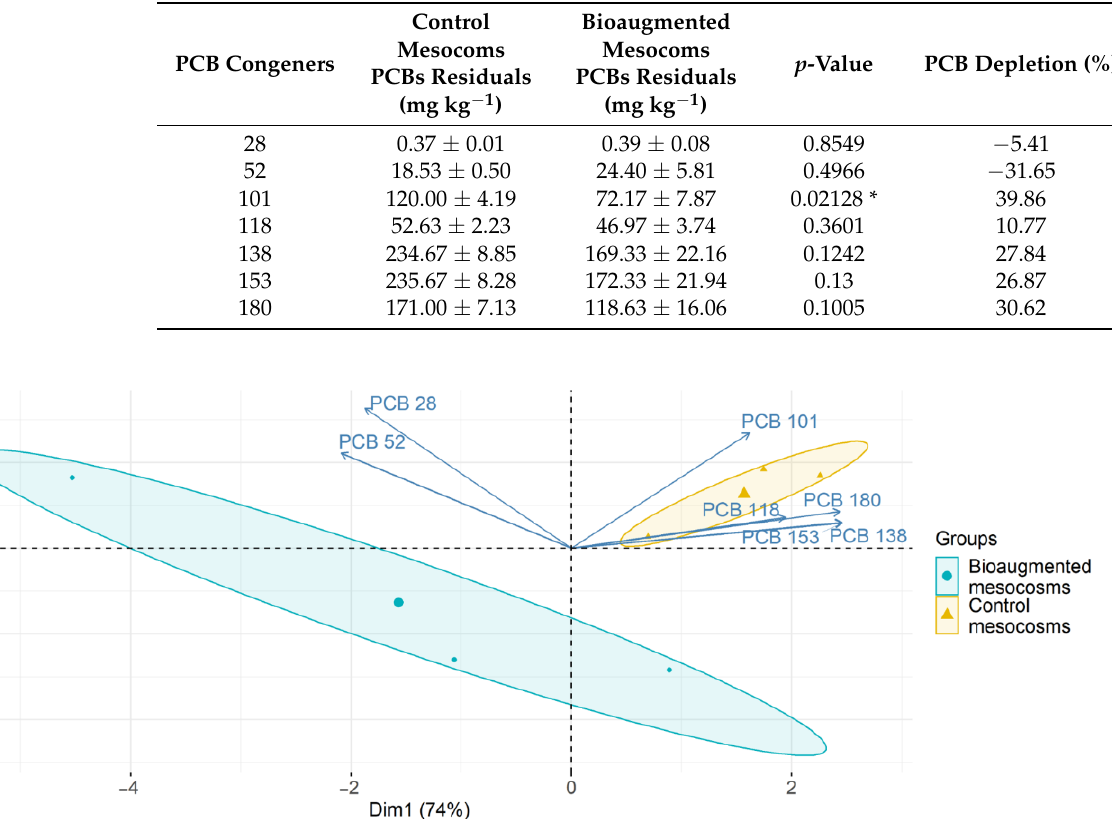
Table 2. Comparison of PCB congener concentrations in bioaugmented and control mesocosms and percentage of degradation of each congener. Asterisk indicates significant differences between treatment (Welch test; p -value < 0.05).